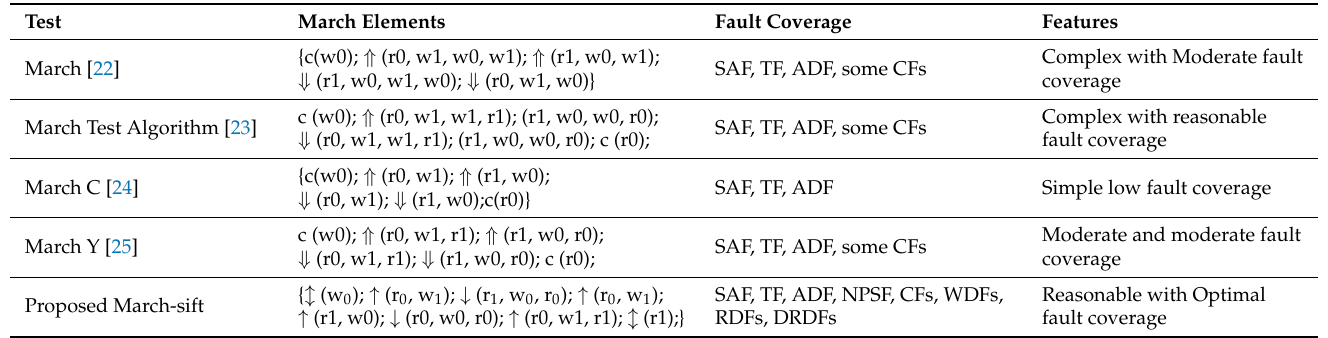
Table 3. Fault test approaches and